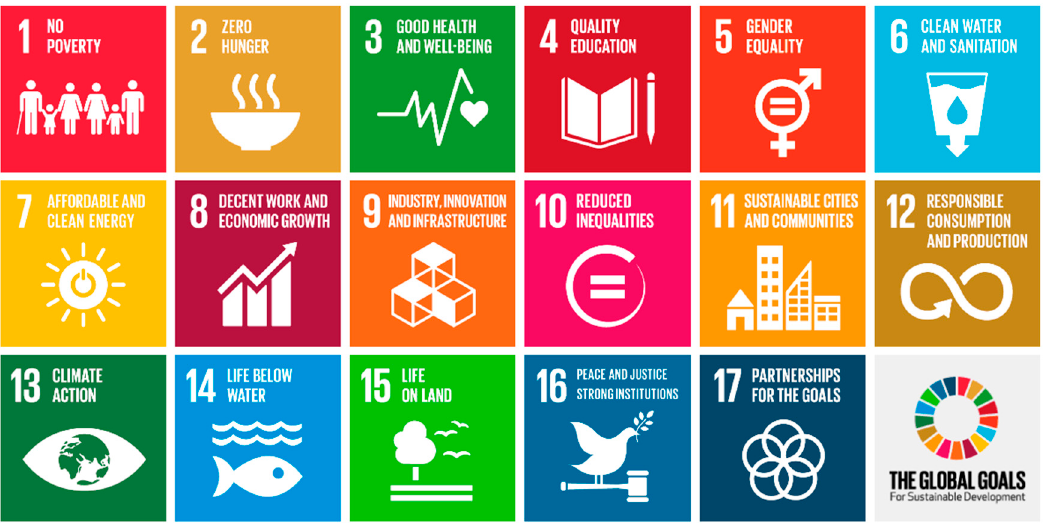
Figure 2. The Global Goals for Sustainable Development (United Nations 2015—permission to use from Sustainable Development Goal (SDG) logo Guidelines).